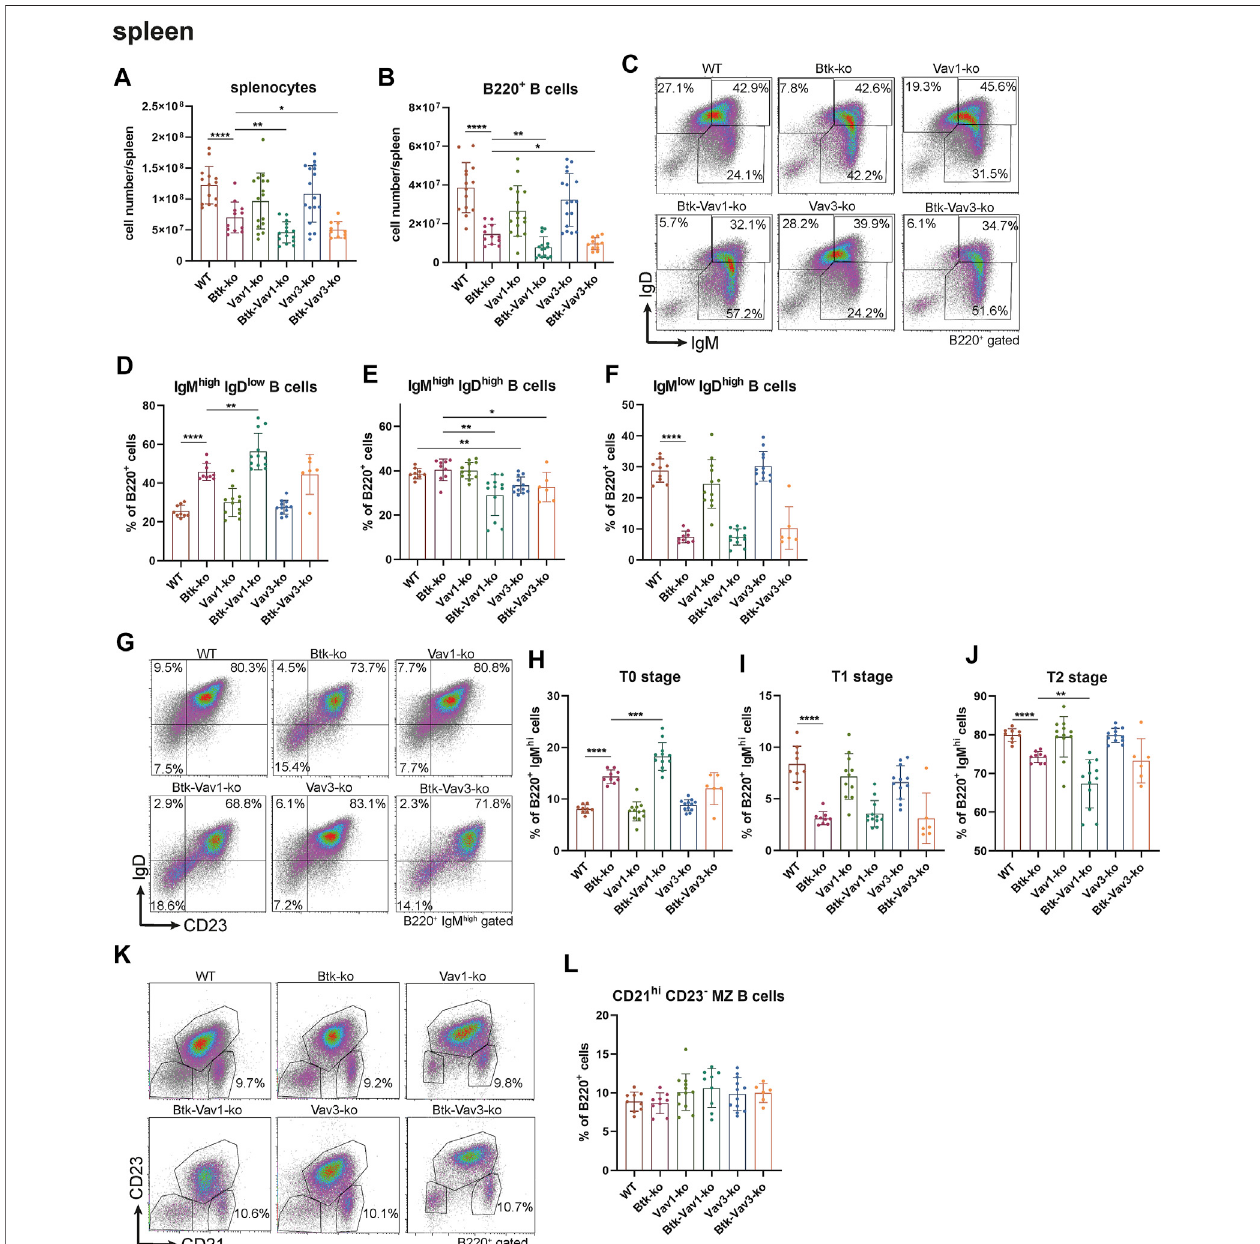
FIGURE 3 | Vav protein de fi ciency affects B cell maturation in the spleen. Statistics of fl ow cytometry representing splenocytes (A) , total B220 + B cells (B) , representative fl owcytometry plots ofsplenicIgM/IgD B cell subpopulations ofeach genotype (C) , statistics of fl owcytometry representing percentage ofIgM high IgD low (D) , IgM high IgD high (E) and IgM low IgD high (F) B cells in the spleen. Representative fl ow cytometry plots of splenic T0, T1 and T2 stage B cell subpopulations of each genotype (G) ,statisticsof fl owcytometryrepresentingpercentageofT0stage (H) ,T1stage (I) andT2stage (J) Bcells.Representative fl owcytometryplots (K) and statistics (L) ofMZBcells.Eachpointrepresentsdatafromasinglemouse.Datainthegraphsareshownasmeans±SD(n=atleast6micepergroup).Dataaremerged from at least three independent experiments. * p < 0.05, ** p < 0.01, *** p < 0.001, and **** p < 0.0001. p -values were determined using a two-tailed Student ’ s t test or Mann-Whitney-U test. Mice were analyzed in an age range from 10 – 16 weeks. Gating strategy is shown in Supplementary Figure S6 .